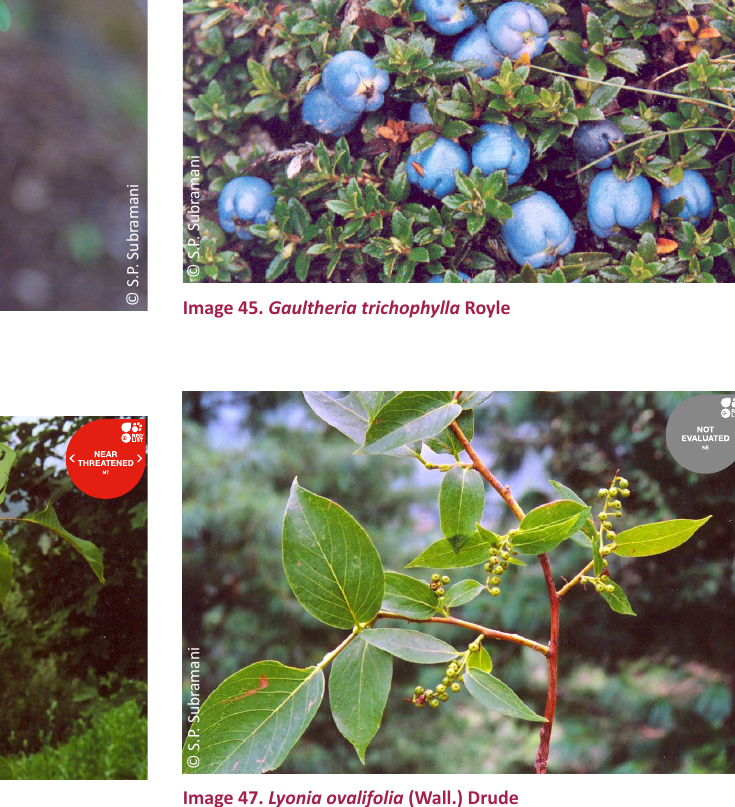
Image 46. Juglans regia L. Image 47. Lyonia ovalifolia (Wall.) Drude